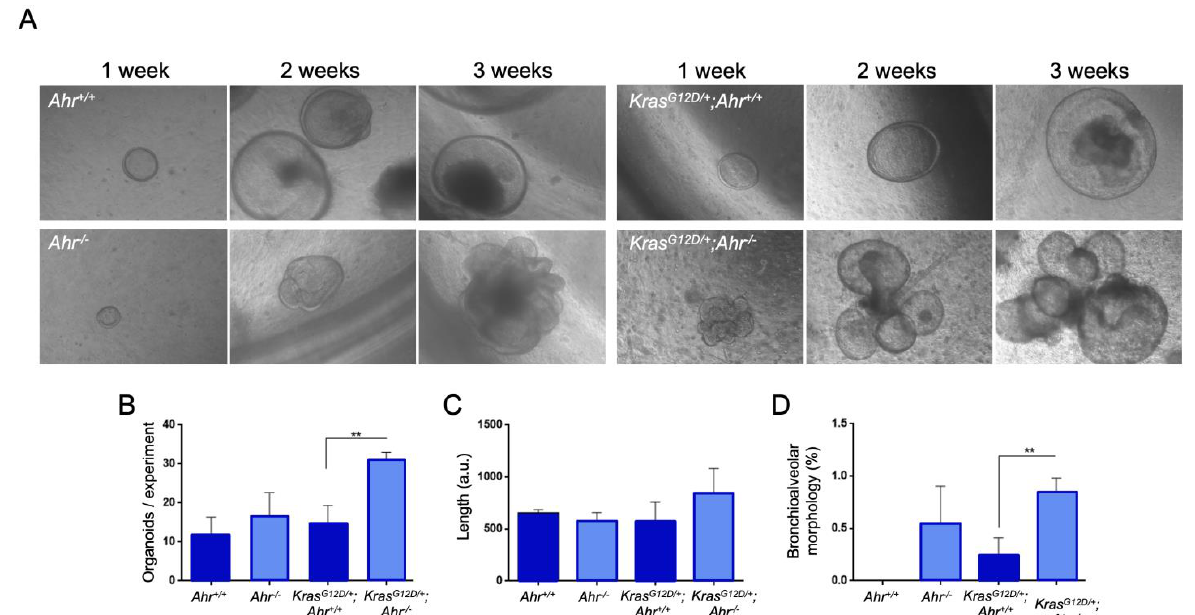
Figure 7. Ahr deficiency favors the formation of lung organoids and their differentiation to bronchioalveolar structures upon K-Ras G12D activation. ( A ) K-Ras G12D/+ ; Ahr +/+ and K-Ras G12D/+ ; Ahr − / − lung cells were cultured under ex vivo conditions for up to three weeks to generate organoids. ( B , C ) The number of organoids generated from 2 × 10 5 initiating cells of each genotype were quantified ( B ) and their length measured ( C ). ( D ) Organoids were analyzed for their bronchioalveolar morphology and the resulting numbers plotted at three weeks after culturing. Data are shown as mean + SD (** p < 0.01). Number of organoids ( N = 4) and replicates of each experiment ( n = 3 – 6). Organoids at passage one were used in all the experiments.